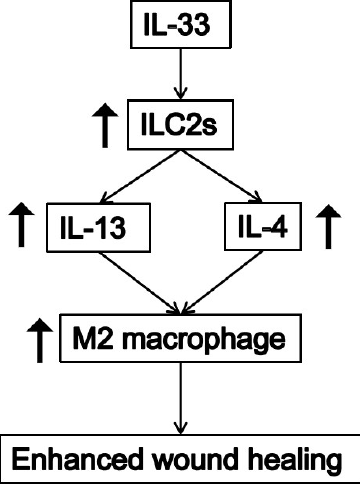
Figure 6. Wound repair mechanisms of IL-33 in skins. IL-33 promotes the proliferation of ILC2 cells, which leads to the up-regulation of IL-13 and IL-4. IL-13 and IL-4 further promote M2 macrophage polarization. All together, these contribute to accelerated and improved wound healing.